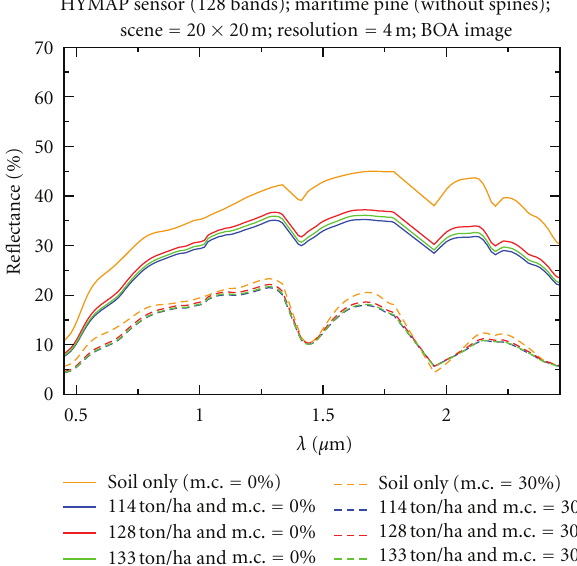
Figure 5: Radar polarimetric radiometry for several biomasses and branches moisture content.